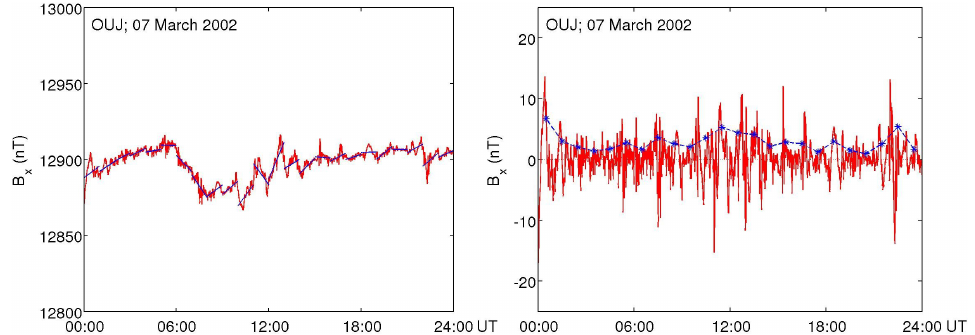
Fig. 4. Similar panels as in Fig. 3, for 7 March 2002, which, although the overall variation is quite small, contains some disturbances. The maximum value of σ H (from B x ) is